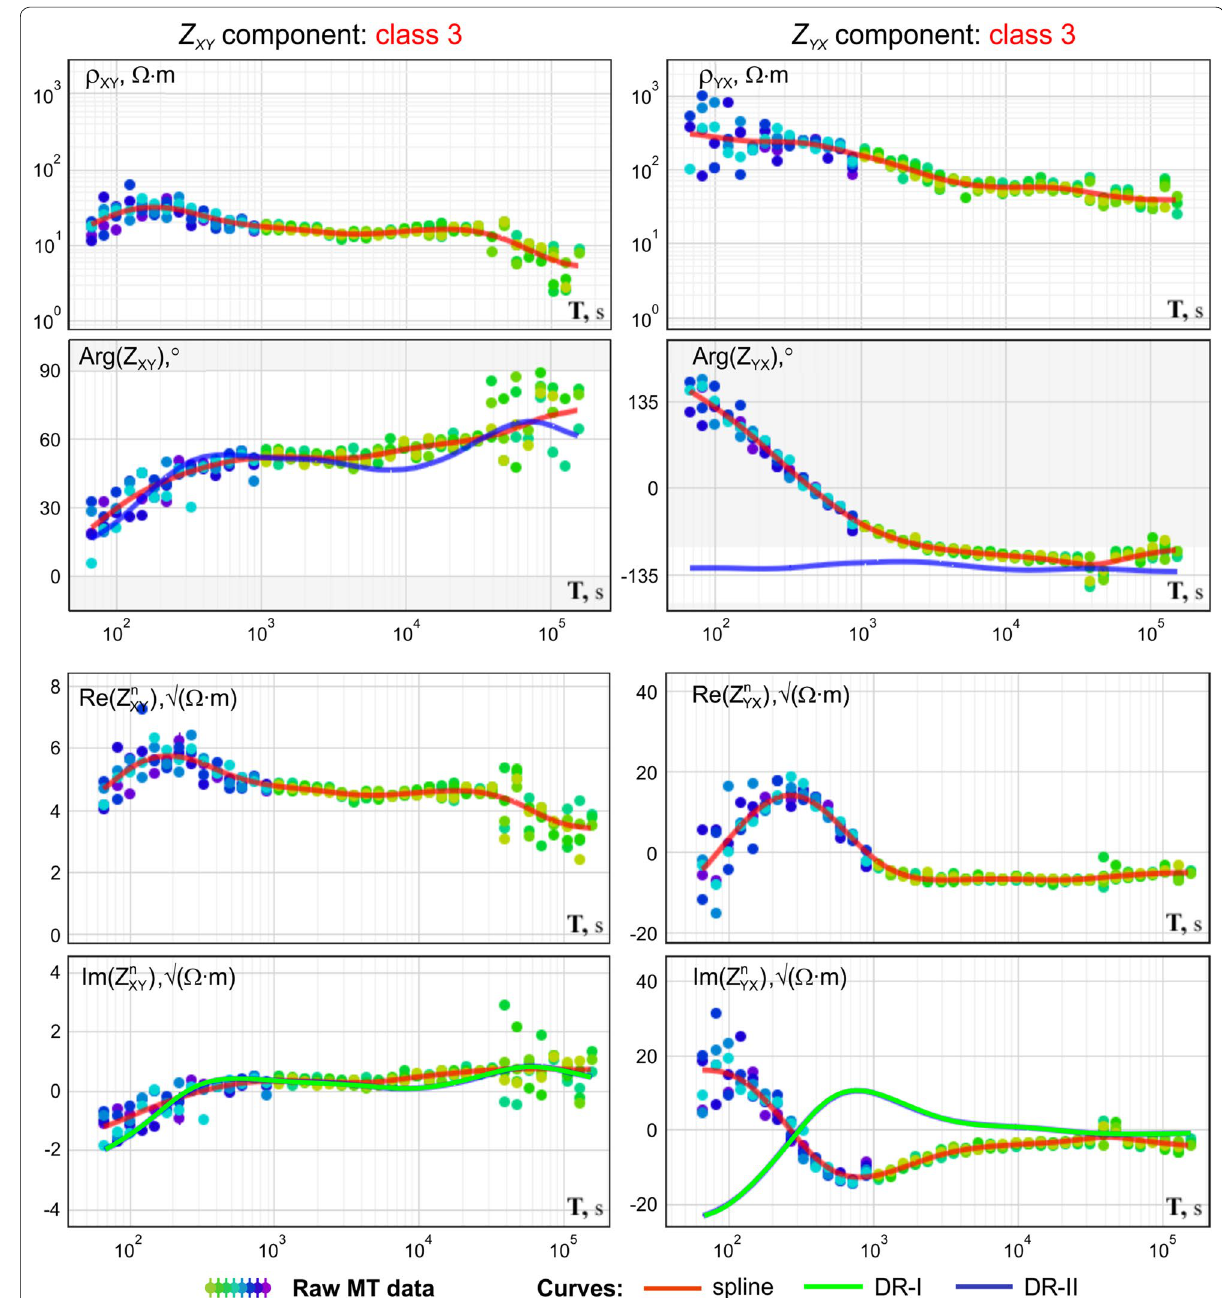
Fig. 19 The DR validity in a non-causal impedance tensor observed at the seafloor site Tris-11 (Tristan da